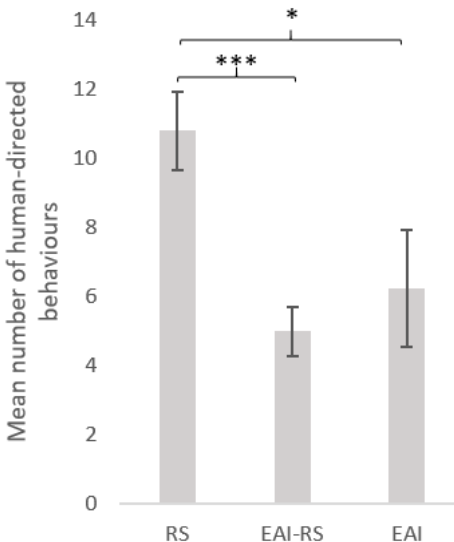
(EAI, EAI-RS, or RS) (AICc: 1066.5, Δ AICc: 0.00), whereas single versus group housing